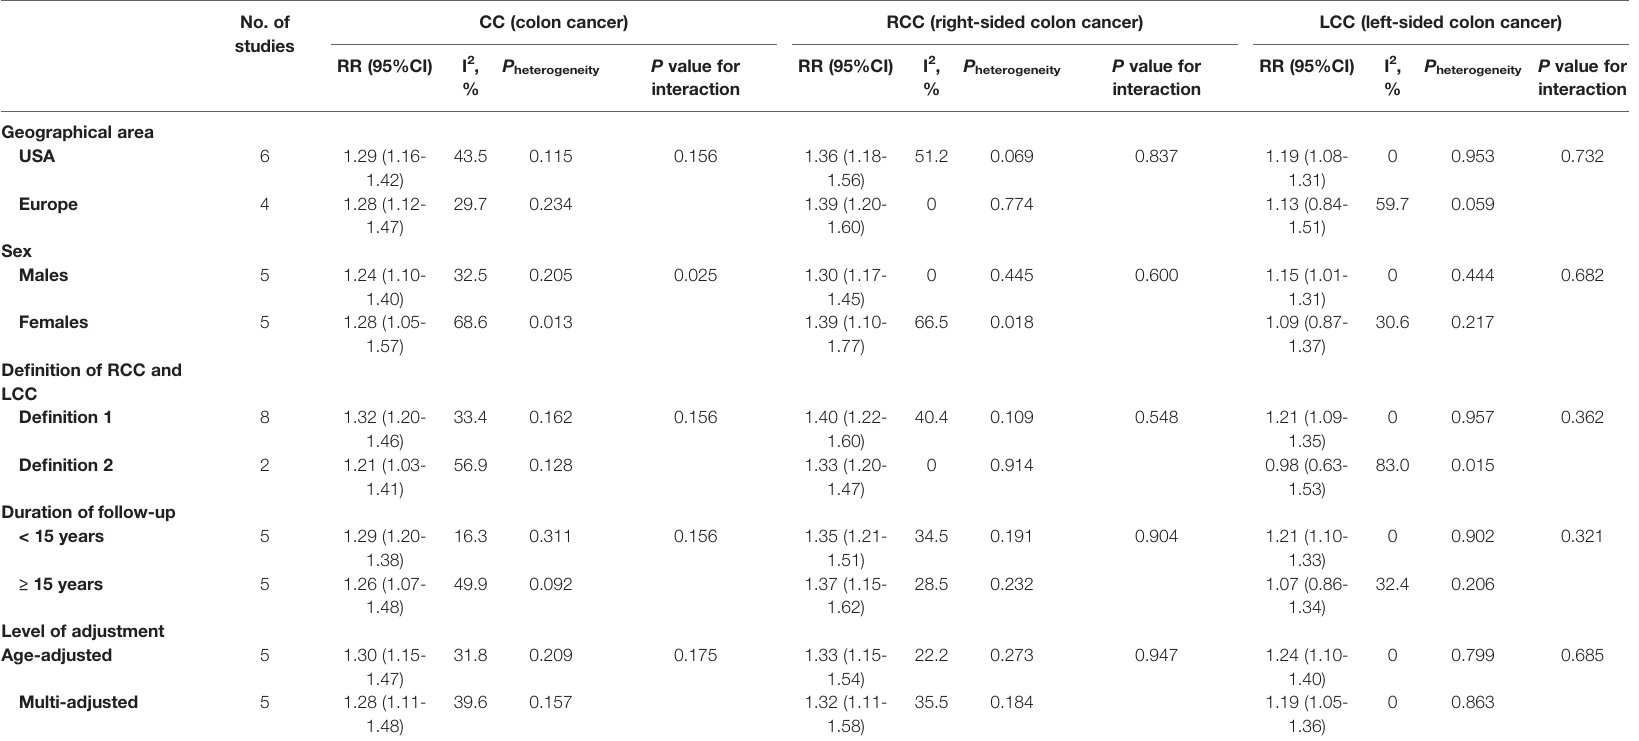
TABLE 2 | Relative risks (RRs) and 95% con fi dence intervals (CIs) for sensitivity